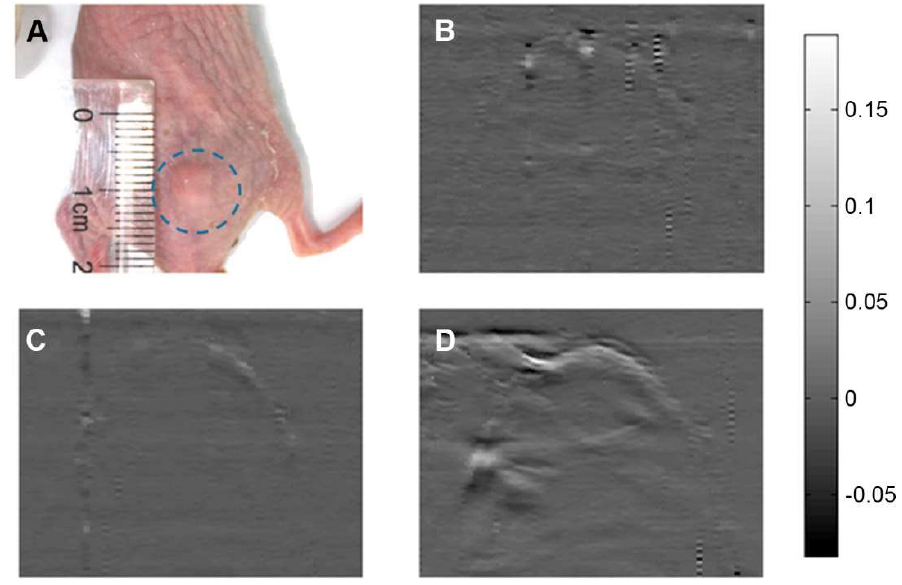
Figure 7. Photoacoustic imaging in vivo with PB coated Au nanoparticles as contrast agents. ( A ) The nude mice tumour before the acquisition. PAT images aquired ( B ) before, ( C ) 2 h after, and ( D ) 22 h after the tail intravenous injection (reproduced with permission from Reference [64]).